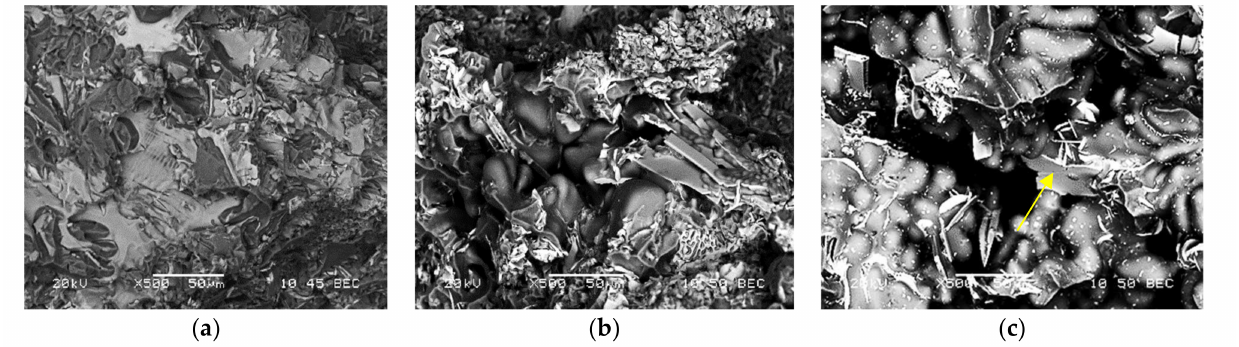
Figure 16. Fracture surface of M2S alloy in: ( a ) as cast, ( b ) SHT, and ( c ) T6 conditions.